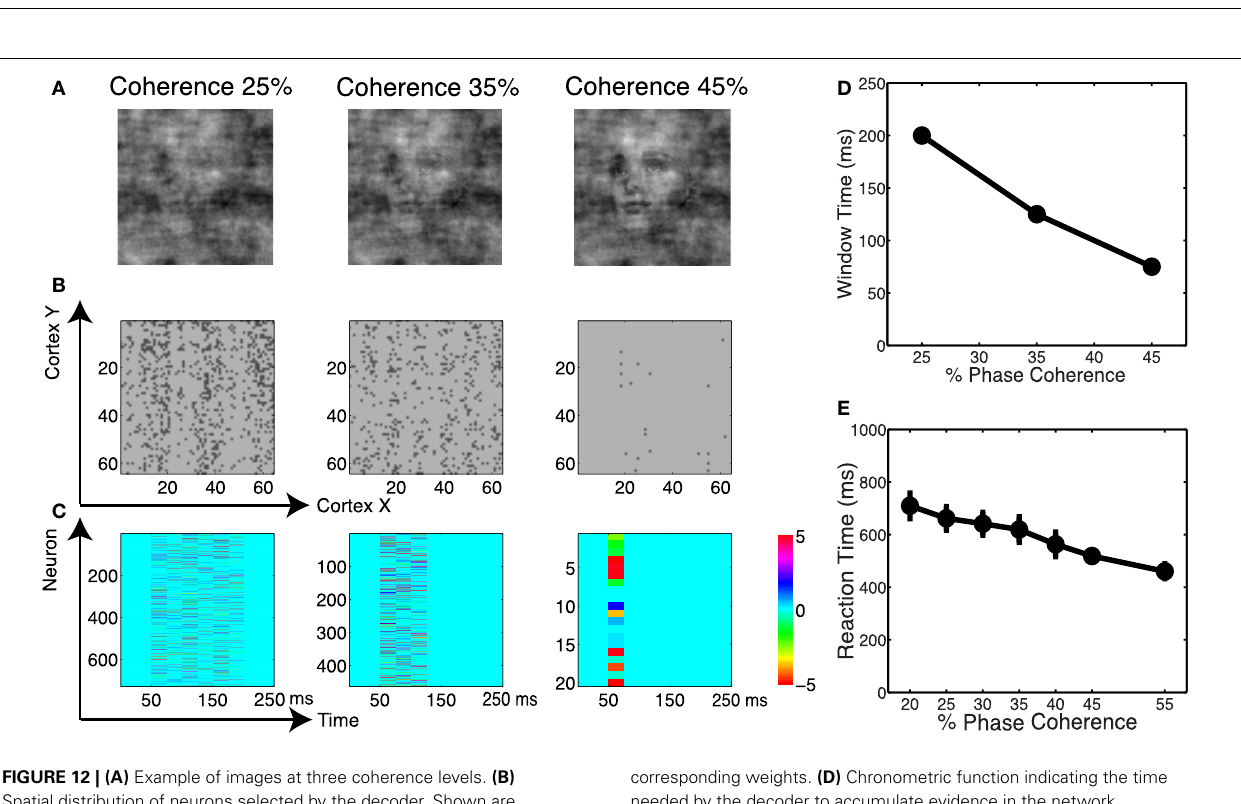
FIGURE 12 | (A) Example of images at three coherence levels. (B) Spatial distribution of neurons selected by the decoder. Shown are neurons in the cortical space, where selected neurons are indicated in black. (C) Temporal windows selected by the decoder together with their